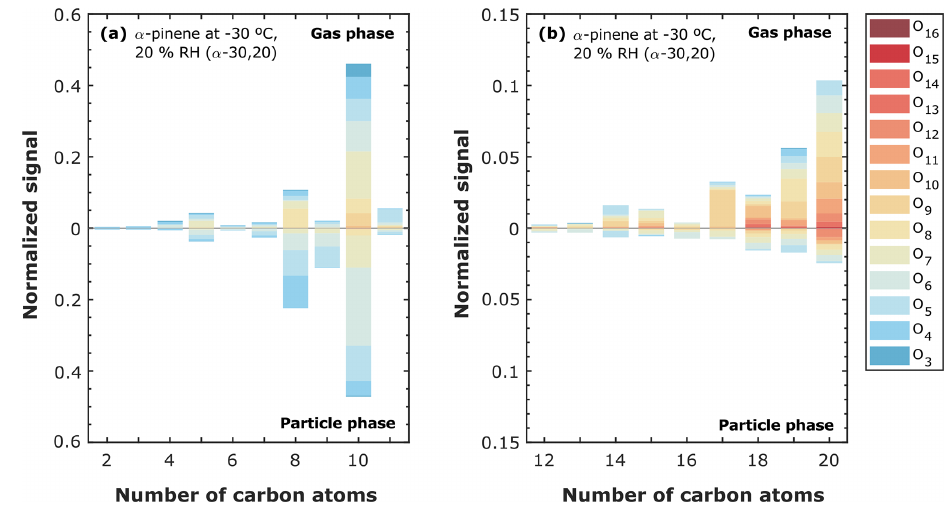
Figure 2. Carbon atom distribution and oxygen atom content in gas- and particle-phase molecules for α -pinene oxidation products at − 30 ◦ C and 20% RH ( α -30,20). Both phases are measured with a nitrate CI-APi-TOF mass spectrometer, while the TD-DMA is coupled to it for particle-phase measurements. (a) Carbon atom distribution C 2 − 11 and (b) carbon atom distribution C 12 − 20 . The level of α -pinene was between 1 and 8ppbv, and the ozone level was stable at ∼ 100ppbv. The intensities are normalized by the total signal in each system and phase. Each color represents a specific number of oxygen atoms in the range of 3 to 16. Table 1. Summary of the main parameters for four pure biogenic new particle formation experiments. Experiment Isoprene α -pinene